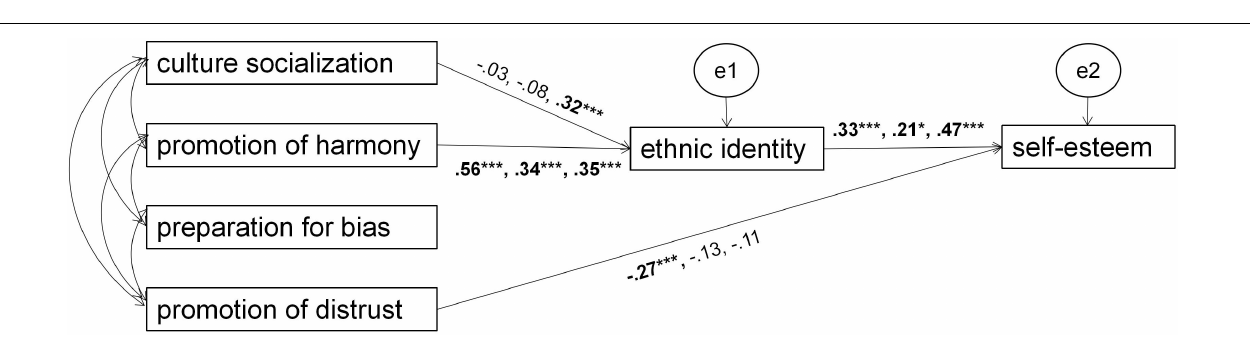
FIGURE 2 | All path standardized coefficients display as the order: first grade, junior grade, senior grade. Path from cultural socialization to ethnic identity is significant only for senior grade, as the path from promotion of distrust to self-esteem is significant only for first grade students. Residual terms and their correlated errors and correlations among the four indicators of ethnic socialization are all omitted from the figure. * p < 0.5 and *** p < 0.001.